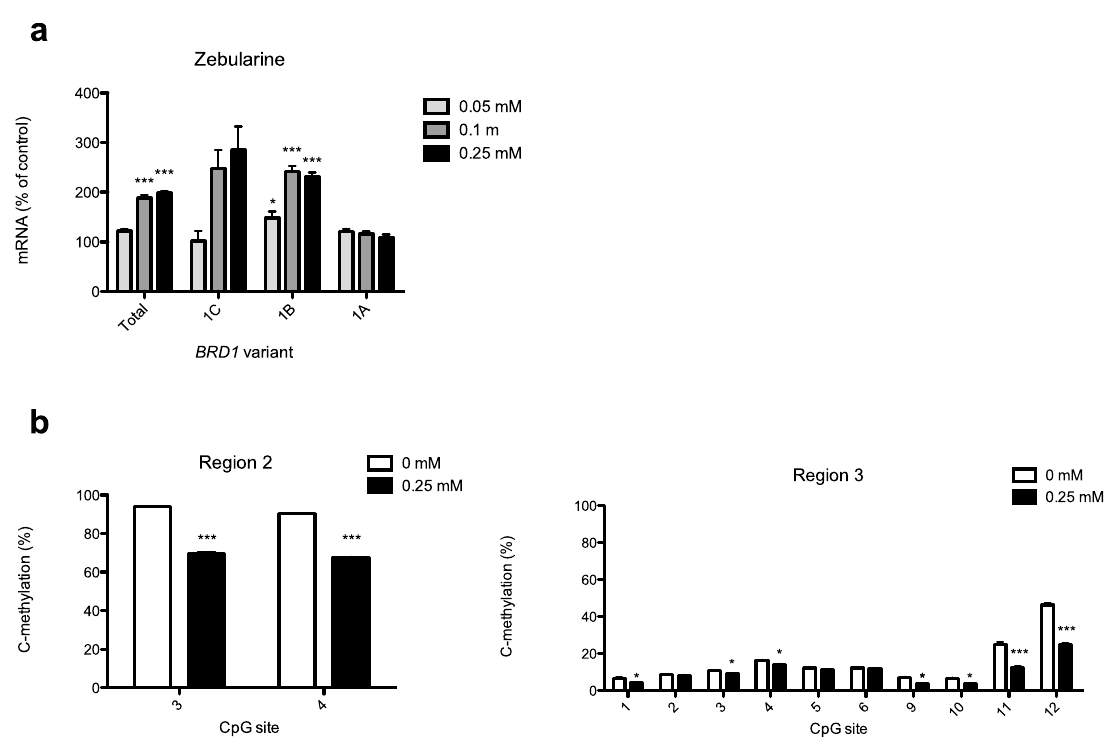
Fig 2. Expression of BRD1 transcripts and methylation proportions in region 2 and 3 following Zebularine treatment in HeLa cells. (a) Expression of BRD1 transcripts in HeLa cells followingZebularinetreatment. The total BRD1 expressionand expressionof transcript variants containing exon 1C, 1B, and 1A were measuredin RNA extracted from HeLa cells following exposureto 0, 0.05, 0.1, or 0.25 mM Zebularinefor 72 hours. PGK1 and TBP were found to be the most stably expressed reference genes and were used for normalization. Data are presentedas mean percentages of the mean value of the control group (no Zebularinetreatment) +SEM (n = 3/group). * p < 0.05, *** p < 0.001, one-wayANOVA with Dunnett’s post-hoc tests. (b) Methylationproportions as determinedby pyrosequencing of region2 and 3 followingZebularinetreatment in HeLa cells. Methylation proportionswere measuredby pyrosequencing of region2 and 3 in DNA extracted from HeLa cells following exposureto 0 or 0.25 mM Zebularinefor 72 hours. Data are presented as mean cytosine methylationproportions (C- methylation) at each CpG site +SEM (n = 3/group). * p < 0.05, *** p < 0.001, unpairedt-test.